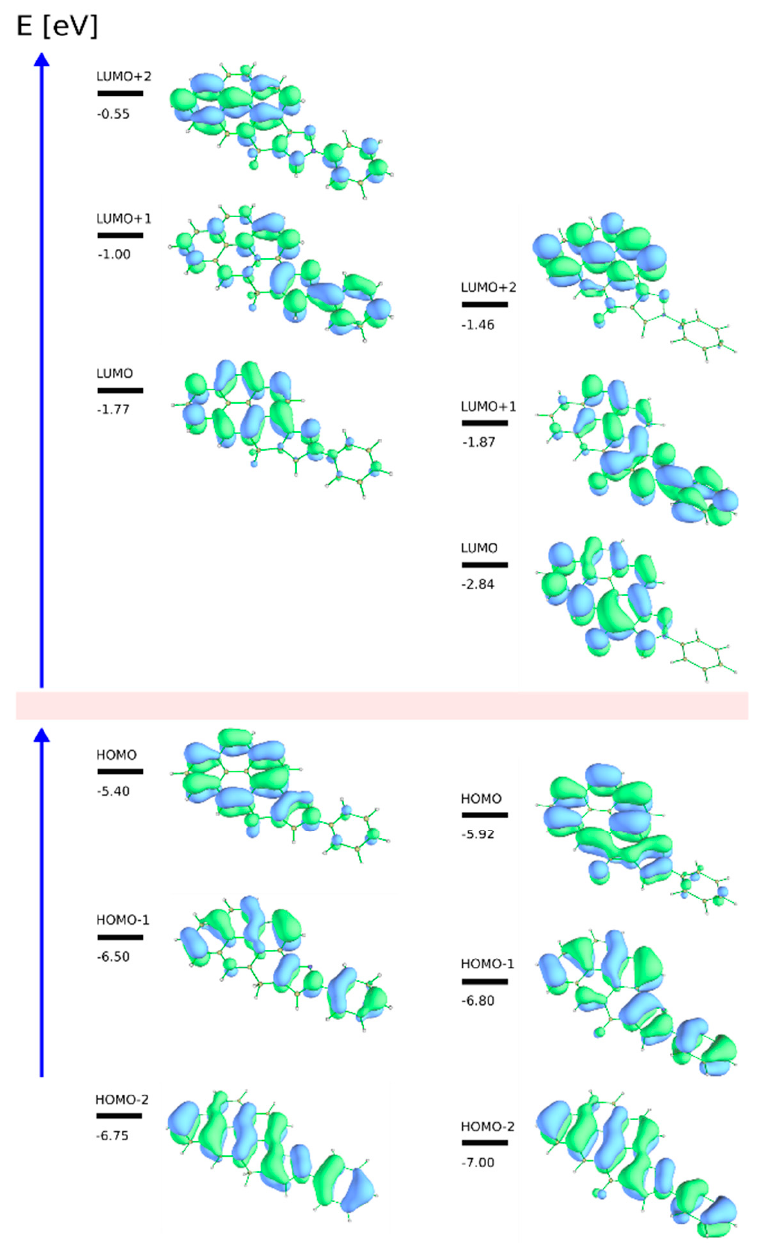
Figure 9. DFT-derived shapes of the molecular orbitals of 3 (left) and 4 (right) and their energies in chloroform solution. Iso-surfaces at 0.024 a.u.